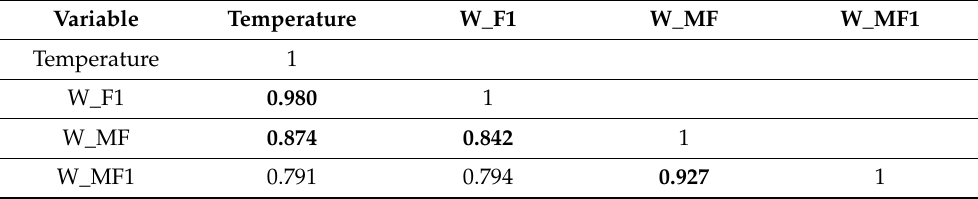
Table 5. Correlation matrix of CMC + CMS.